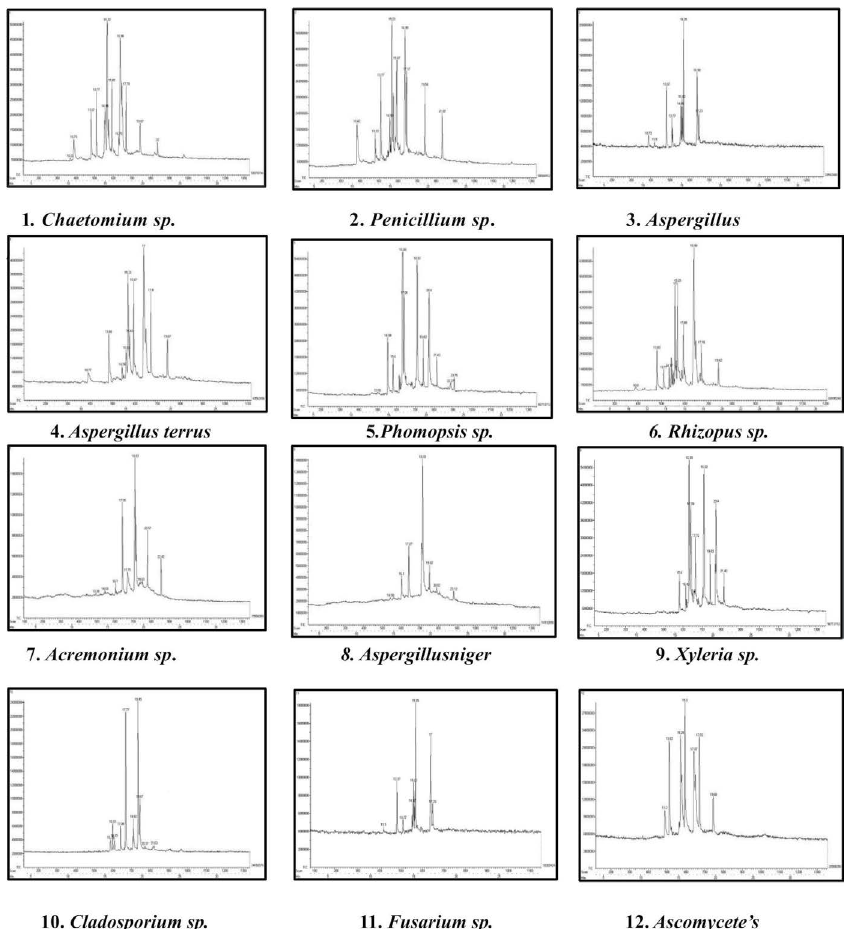
Fig. 2. GC-MS chromatogram analysis showed multiple peaks which indicating the presence of many compounds in crude endophytic fungal Ethyl acetate